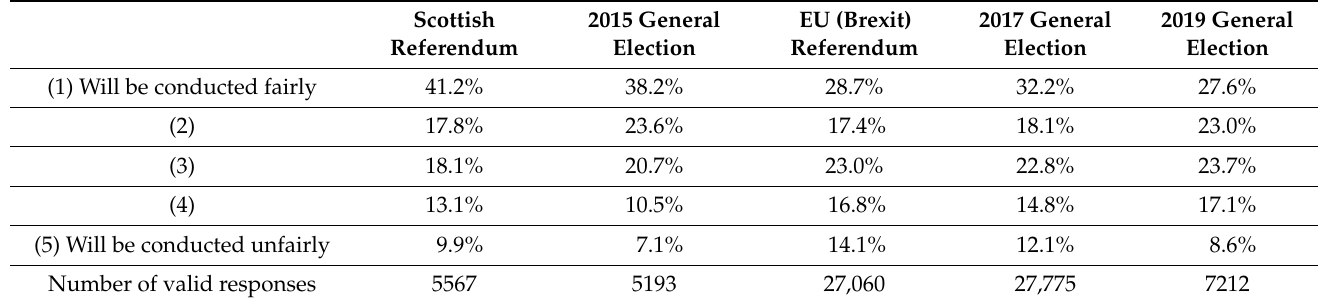
Table 2. Expectations of (un)fairness of different electoral